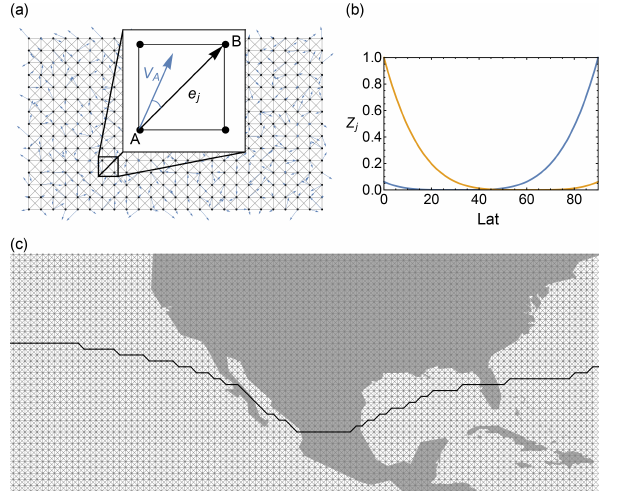
Figure 1. Definition of edge costs: (a) shows all nodes and edges as well as the wind velocities of the considered node (blue arrows) in the grid. The edge costs are computed from wind velocities (length of blue arrows, X j ), wind direction (angle between blue arrow and black edge, Y j ) and the latitudinal position Z j . (b) indicates the third cost term Z j of the STJ (blue) and PFJ (orange). The edge cost is very low in the vicinity of φ clim = 30 ◦ N for the STJ and φ clim = 60 ◦ N for the PFJ and very far away from φ clim . (c) shows the STJ (black line) in the network graph over North and Central America for a certain time